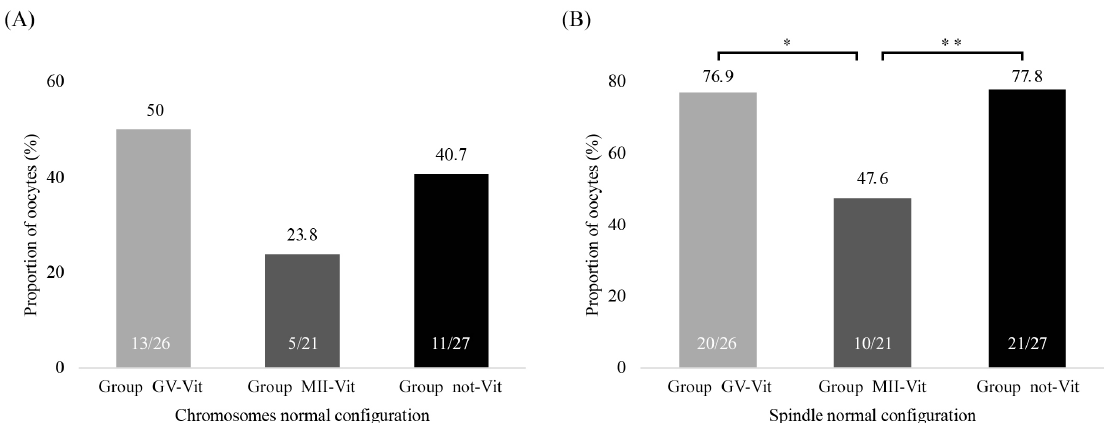
Figure 4. Chromosomes and spindle normal configuration of the oocytes in the three groups of study (Group GV-Vit, Group MII-Vit, and Group not-Vit). ( A ) Chromosomes normal configuration, p -value > 0.05. ( B ) Spindle normal configuration * p -value Group GV-Vit vs. Group MII-Vit = 0.038 and ** p -value Group MII-Vit vs. Group not-Vit = 0.03.